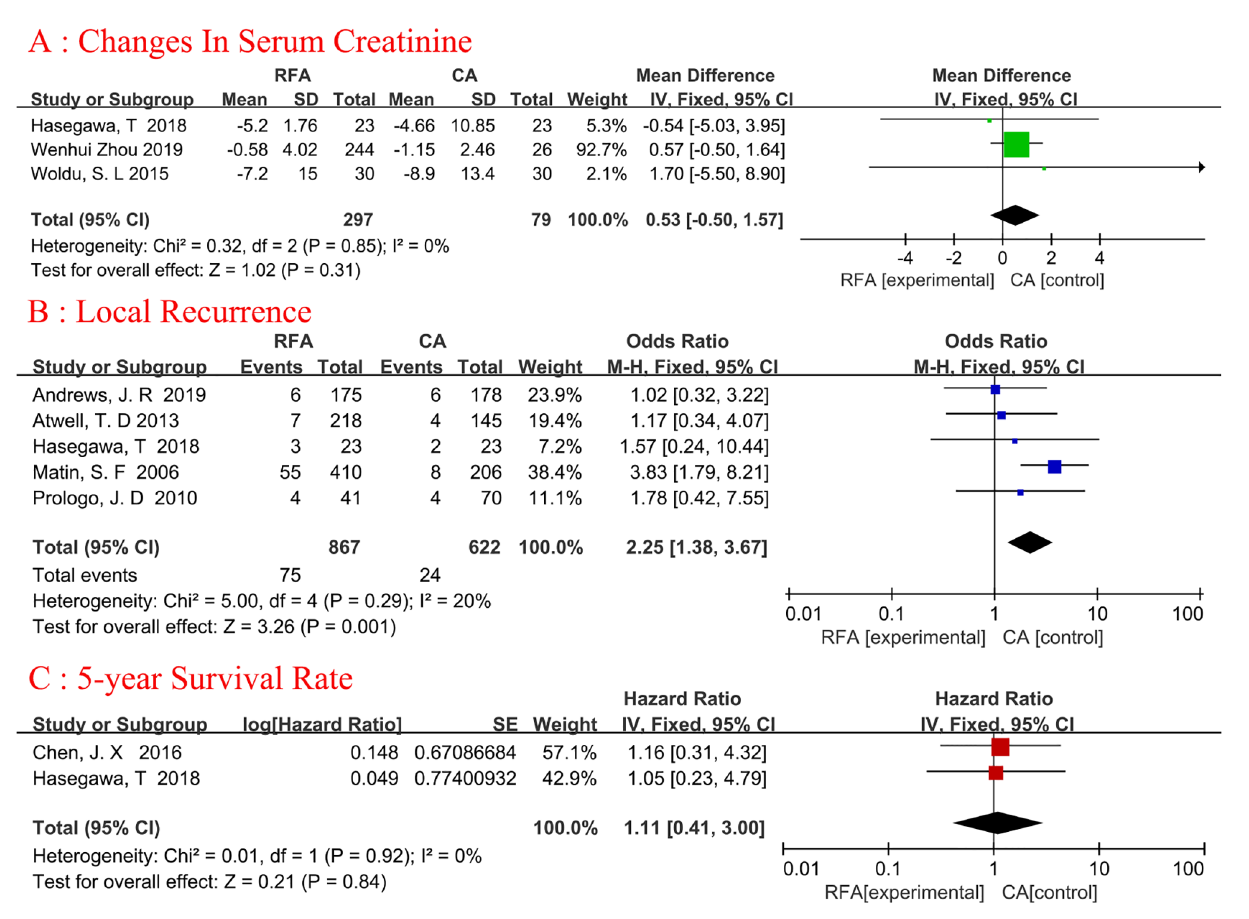
FIGURE 4 | Forest plot and meta-analysis of changes in serum creatinine (A) , local recurrence (B) , and 5-year survival rate (C)